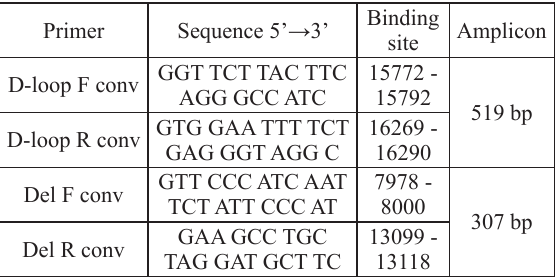
Primers used for conventional PCR amplification of total mtDNA (D-loop) and deleted mtDNA